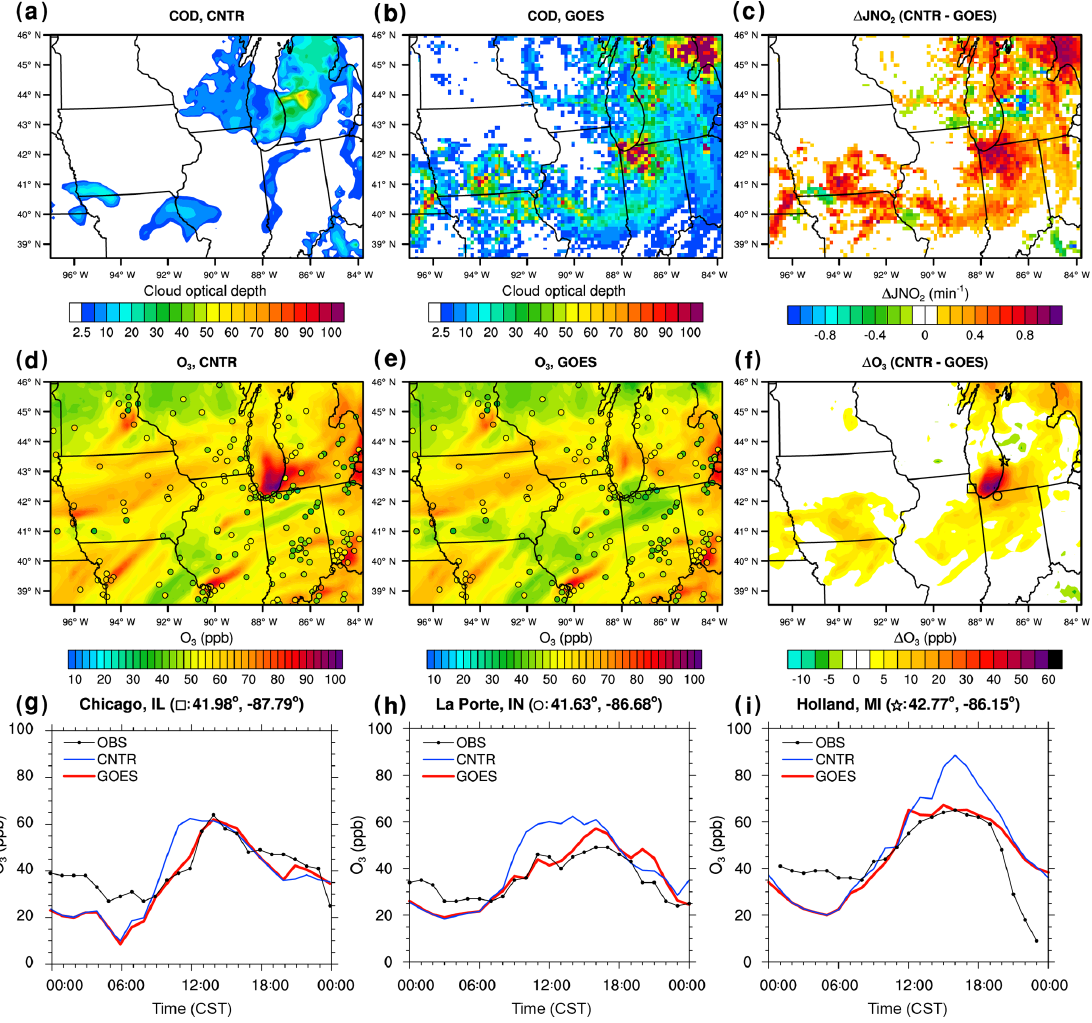
Figure 4. Horizontal distributions of cloud optical depth at 13:00CST ( = 19:00UTC) on 8 July 2013 (a) in the CNTR simulation and (b) in the GOES simulation. Horizontal distributions of O 3 at 13:00CST on 8 July 2013 at the lowest model level (shaded) (d) in the CNTR simulation and (e) in the GOES simulation. The circles indicate EPA ozone measurements. Panels (c) and (f) show the difference in J NO 2 and O 3 , respectively, between the simulations (i.e., CNTR simulation minus GOES simulation). (g–i) Time series of O 3 at the square (Chicago, IL), circle (La Porte, IN), and star (Holland, MI) that are marked in (f) ,